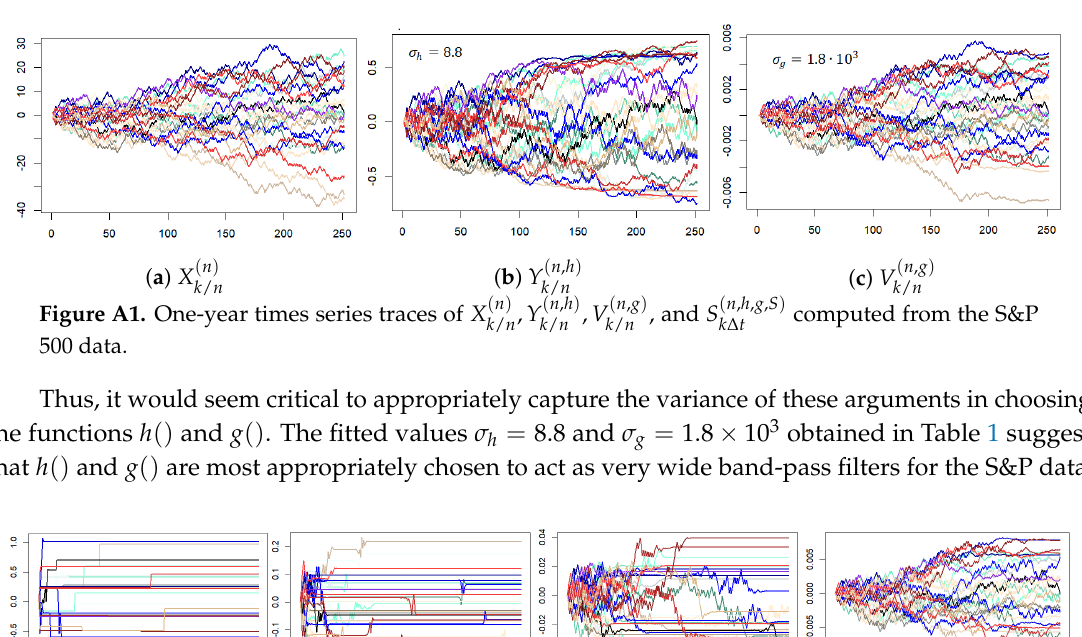
( n , g ) with various values of σ g showing the band-pass filter effect of the k / n